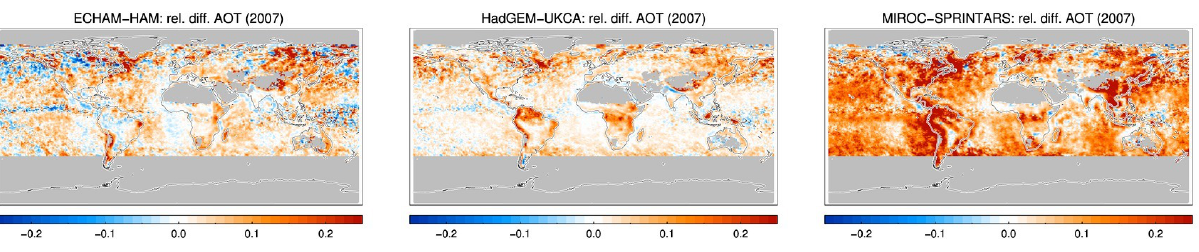
Figure 15. Relative temporal sampling error using MODIS-NRL Aqua AOT sampling. The yearly averages are constructed from daily data, excluding days for which no observations were present. This figure can be compared to the bottom row of Fig. 8 (but note that the colour bar has half its range). Grey colors indicate no observations